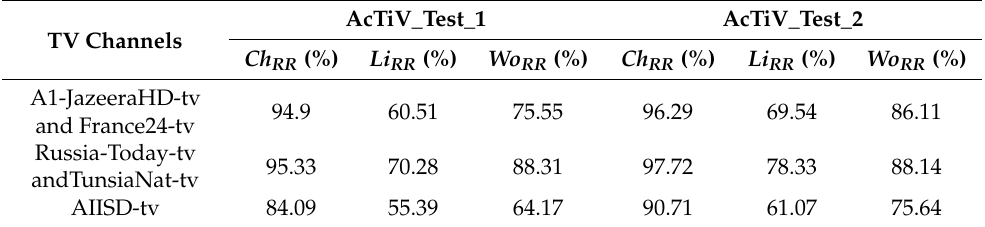
Table 5. Proposed architectural results on AcTiV